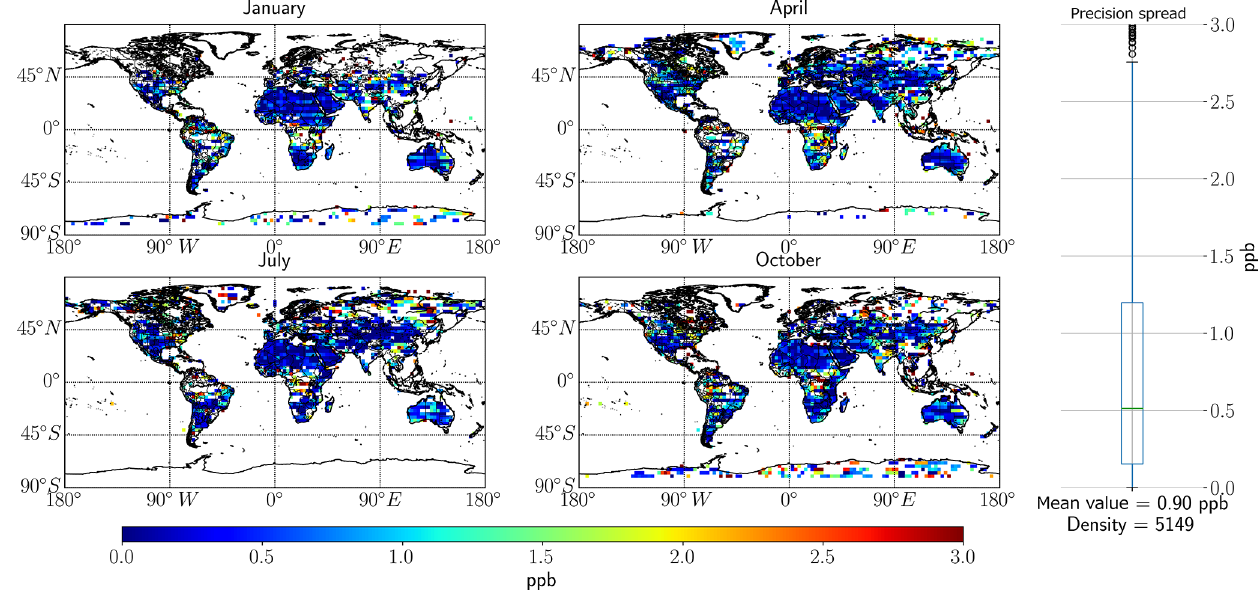
Figure A2. As Fig. A1 but focused on the SWIR3 band.